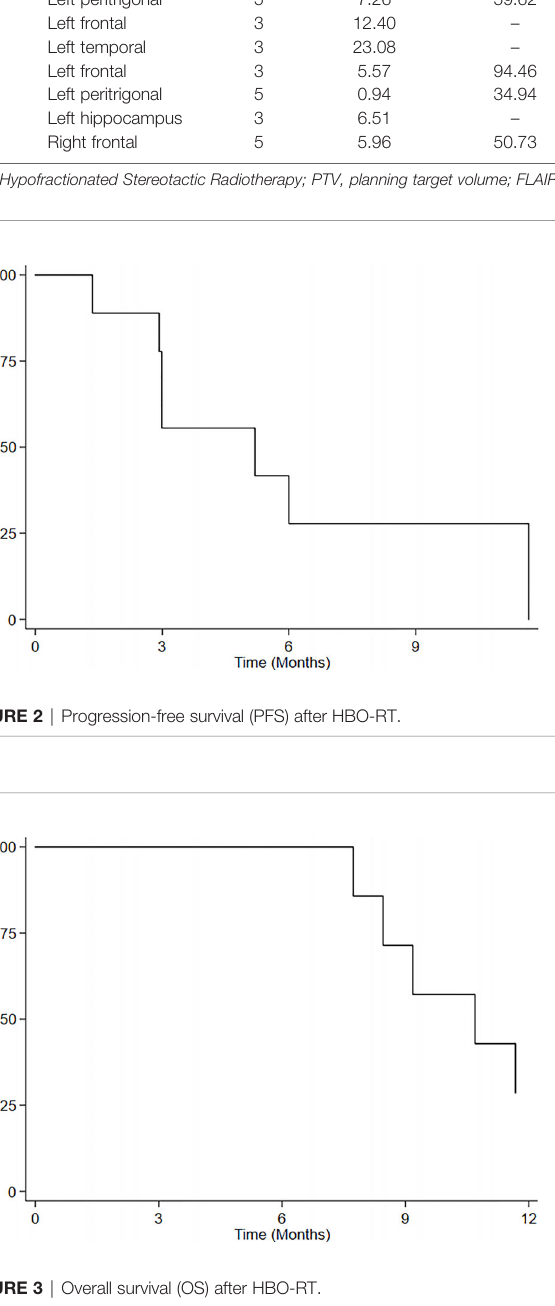
FIGURE 3 | Overall survival (OS) after